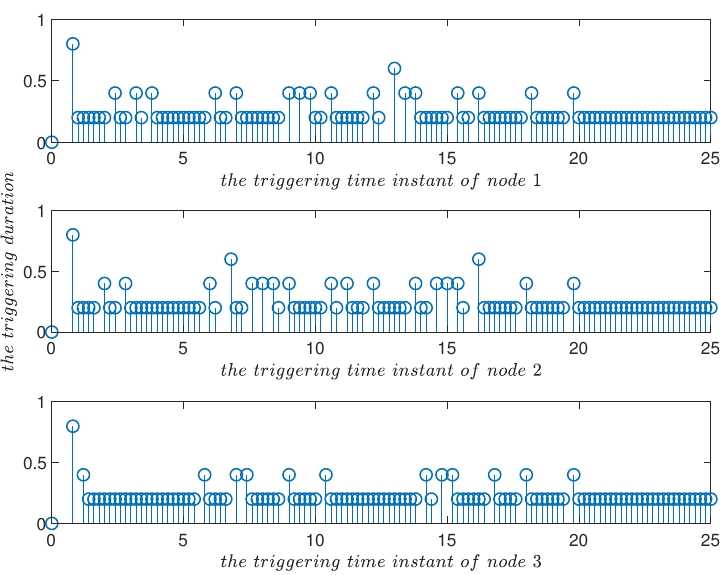
Figure 12. Triggering time instants and their duration in the improved event-triggered scheme for (cid:101) 1 ( t ) = 0.2 in Example 1. Compared with Figure 11, triggering parameter (cid:101) 1 ( t ) played a role in adjusting the triggering frequency.